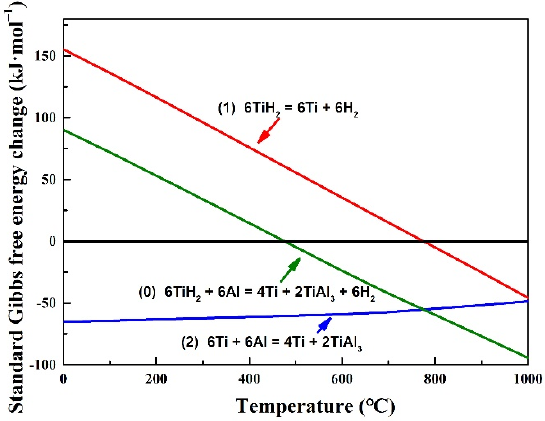
Figure 2. Gibbs free energy change ( Δ G) with temperature of reactions (1) and